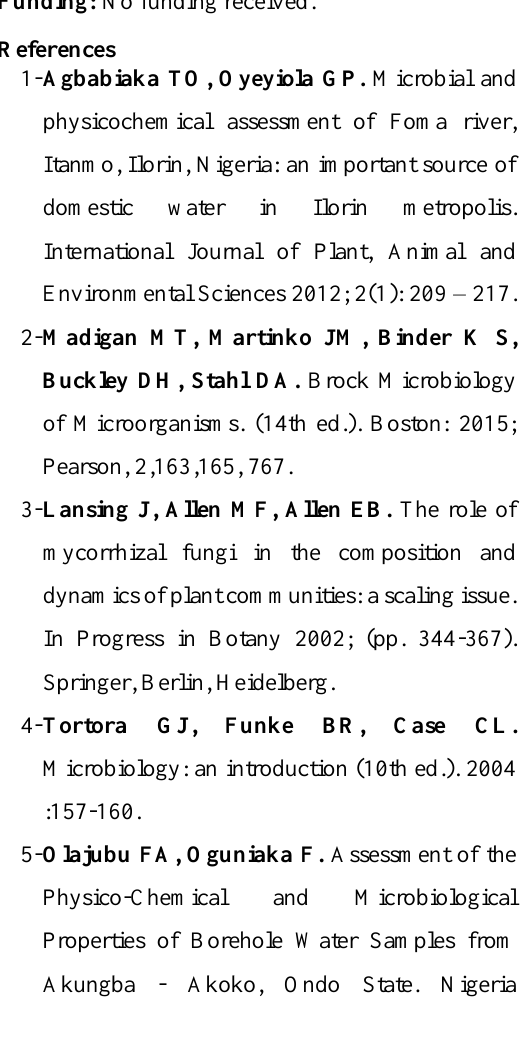
Plate 1. Polymerase chain reaction (PCR) product of electrophoresis gel image showing the DNA fragments of bacterial isolates subjected to 16 Svedberg RNA